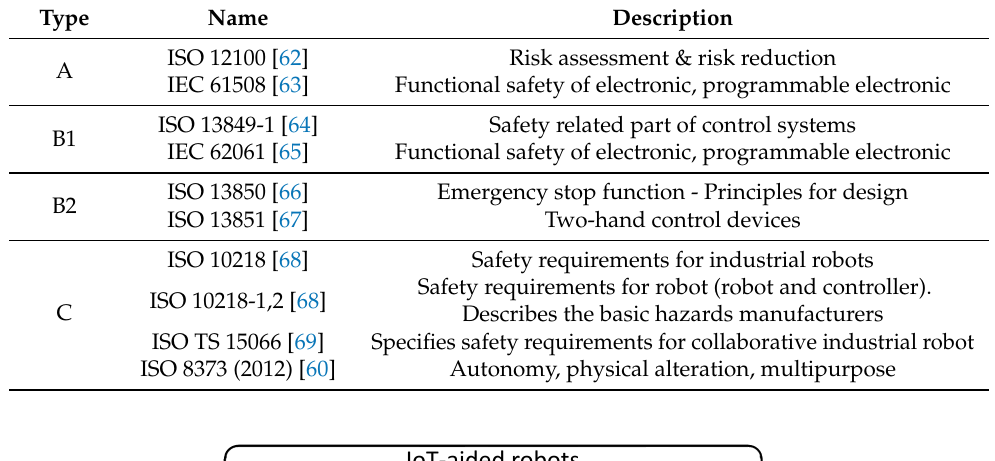
Table 1. ISO safety standards for robotic solutions.